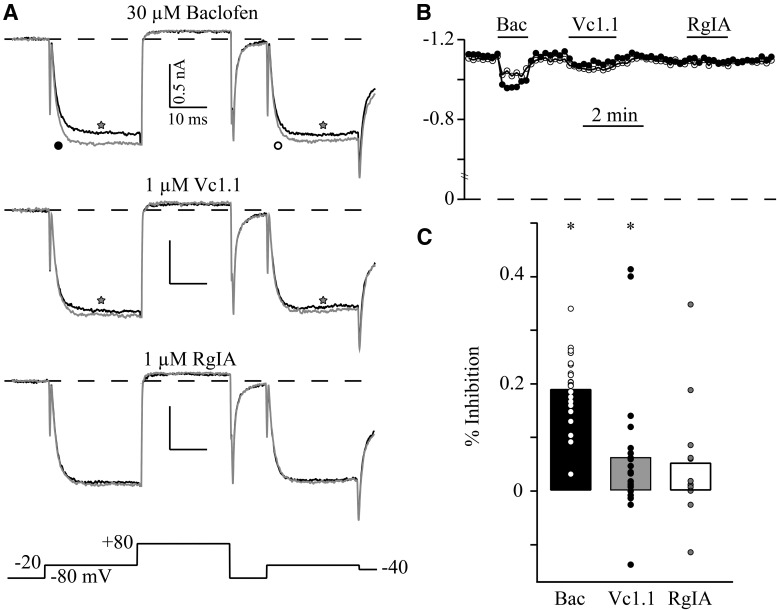
The effect of α9a10 nAChR blockers Vc1.1 and RgIA on CaV currents in rat DRG neurons. A, Superimposed traces of Ba2+ currents from one cell in the absence (grey) and presence (black) of 30 µM baclofen, 1µM Vc1.1, and 1 µM RgIA. Voltage protocol is shown at the bottom. B, The blocking time course of prepulse (filled circles) and postpulse (empty circles) current by baclofen, Vc1.1, and RgIA. C, The plot shows mean percent CaV current inhibition by baclofen (n = 21), Vc1.1 (n = 21), and RgIA (n = 12), along with the individual data points to illustrate the large variability in responses. * indicates significant inhibition (p < 0.05).